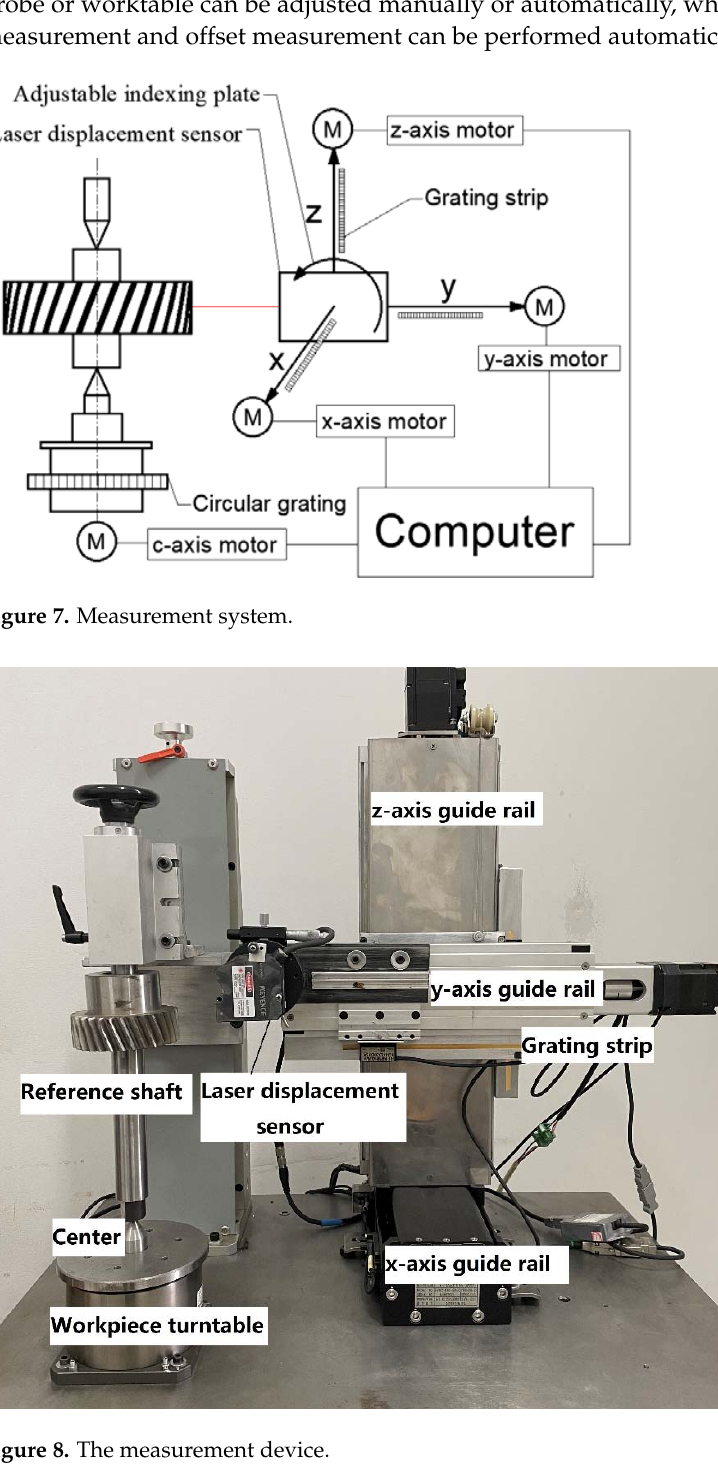
Figure 8. The measurement device.